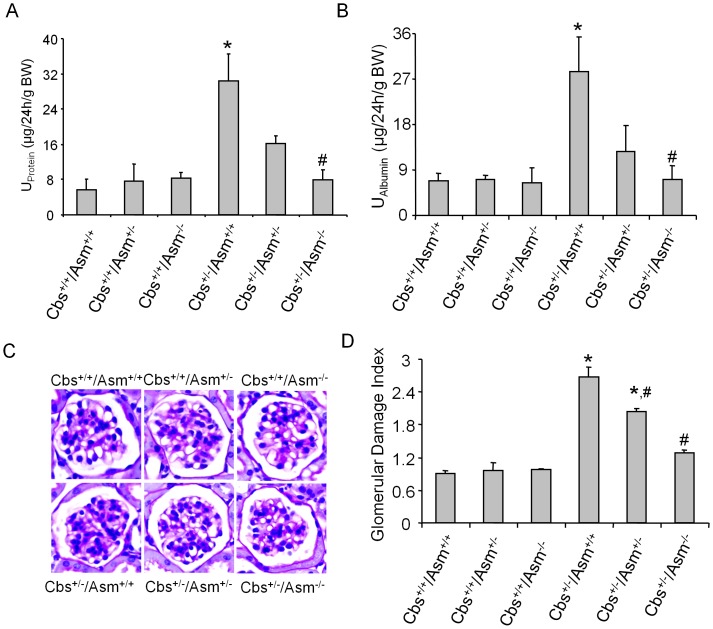
Glomerular injury in Cbs+/+/Asm+/+, Cbs+/+/Asm+/−, Cbs+/+/Asm−/−, Cbs+/−/Asm+/+, Cbs+/−/Asm+/− and Cbs+/−/Asm−/− mice.A: Values are arithmetic means ± SEM (n = 6 each group) of urinary total protein excretion, B: Urinary albumin excretion in Cbs+/+/Asm+/+, Cbs+/+/Asm+/−, Cbs+/+/Asm−/−, Cbs+/−/Asm+/+, Cbs+/−/Asm+/− and Cbs+/−/Asm−/− mice. C: Photomicrographs show typical glomerular structure (original magnification, x400) in Cbs+/+/Asm+/+, Cbs+/+/Asm+/−, Cbs+/+/Asm−/−, Cbs+/−/Asm+/+, Cbs+/−/Asm+/− and Cbs+/−/Asm−/− mice. D: Summarized data of glomerular damage index (GDI) by semi-quantitation of scores in 6 different groups of mice (n = 6 each group). For each kidney section, 50 glomeruli were randomly chosen for the calculation of GDI. * Significant difference (P<0.05) compared to the values from Cbs+/+/Asm+/+ mice; # Significant difference (P<0.05) compared to the values from Cbs+/−/Asm+/+ mice.